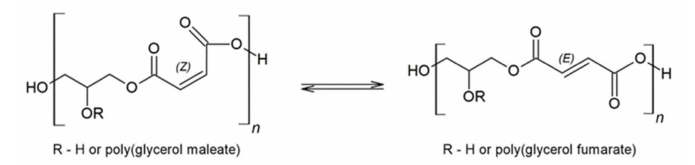
Figure 4. Isomerisation of PGMal and